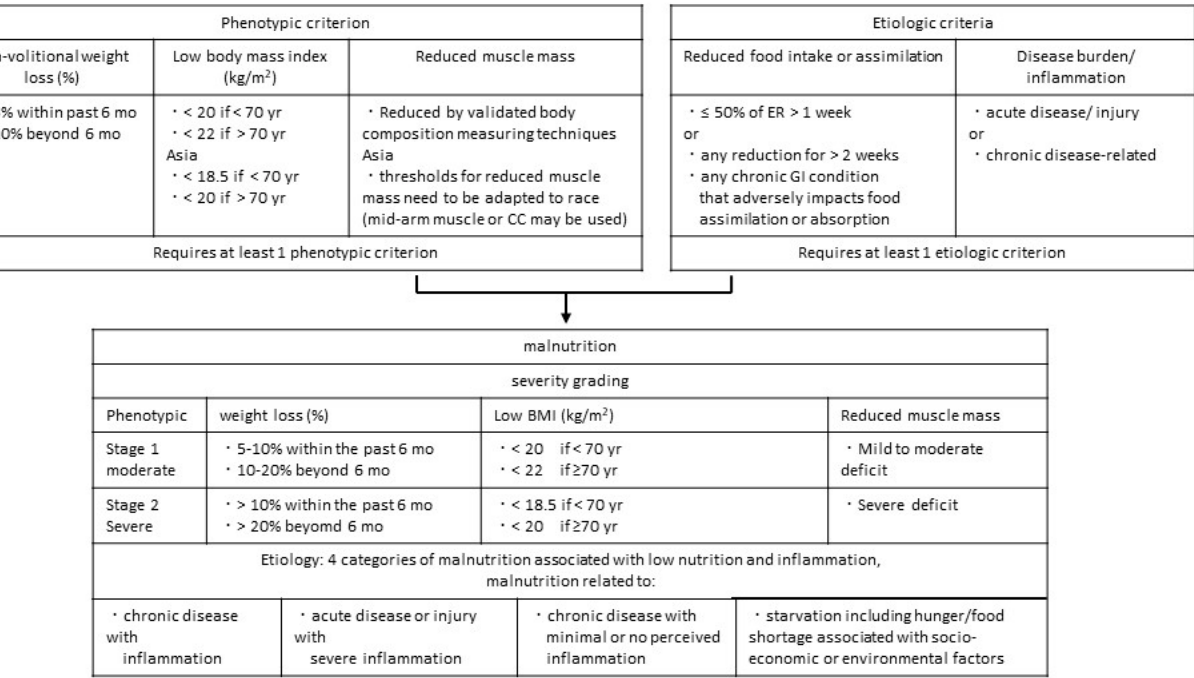
Figure 2. Malnutrition diagnosis using Global Leadership Initiative on Malnutrition (GLIM) stan- dards. Abbreviations: CC, calf circumference; ER, emergency requirements; GI, gastrointestinal; mo, month; yr, year. Modified from